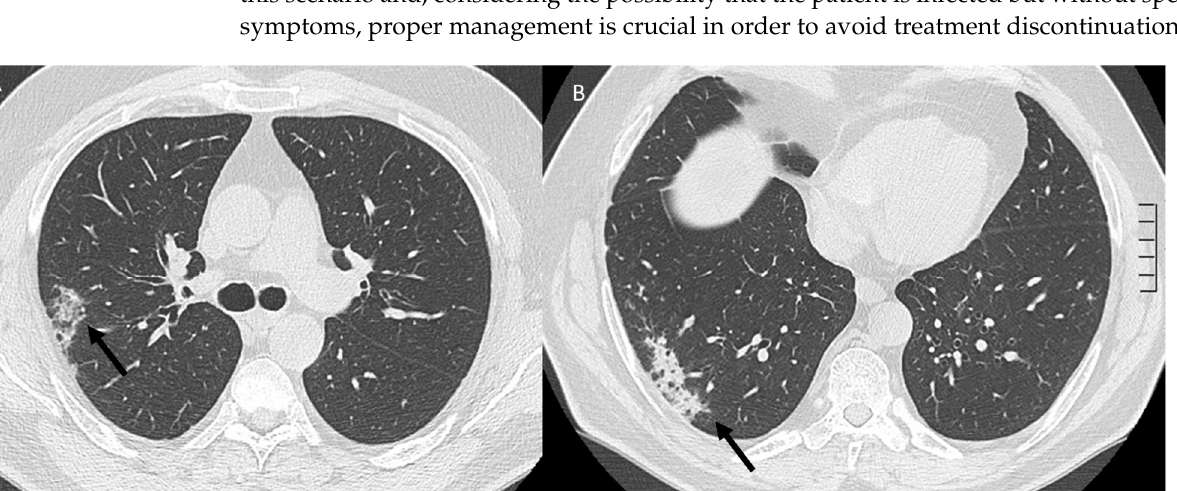
Figure 9. CT assessment (( A ): axial plane; ( B ): coronal plane of PLC in pancreatic cancer patient: irregularly interlobular septal thickening or nodular thickening (arrows). Dyspnea is the main symptom, but often and especially in the early stages, it starts asymptomatically.